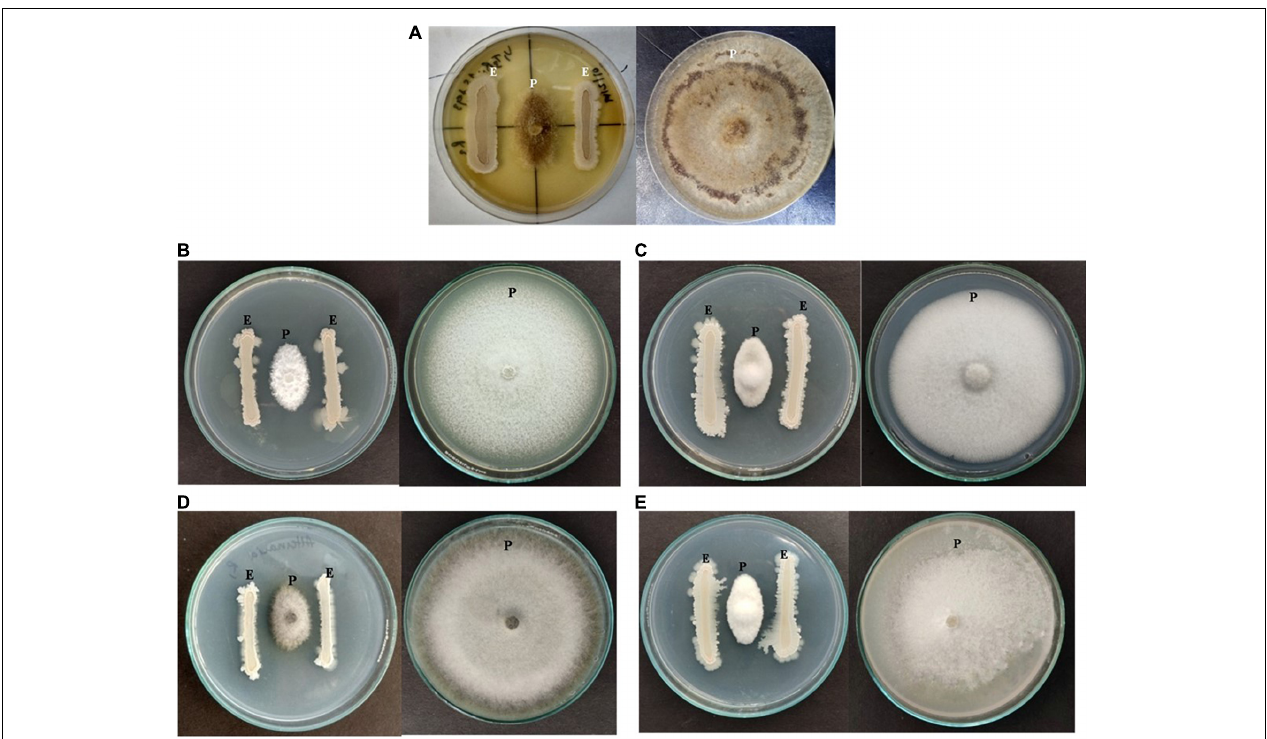
FIGURE 5 | Antagonizing effect of strain NKIT9 against (A) Rhizoctonia solani, (B) Verticillium lateritium (C) Botrytis cinerea, (D) Alternaria solani , and (E) Fusarium solani after 6 days of inoculation (“E” represents endophytic bacterial strain whereas “P” represents Pathogenic fungi).